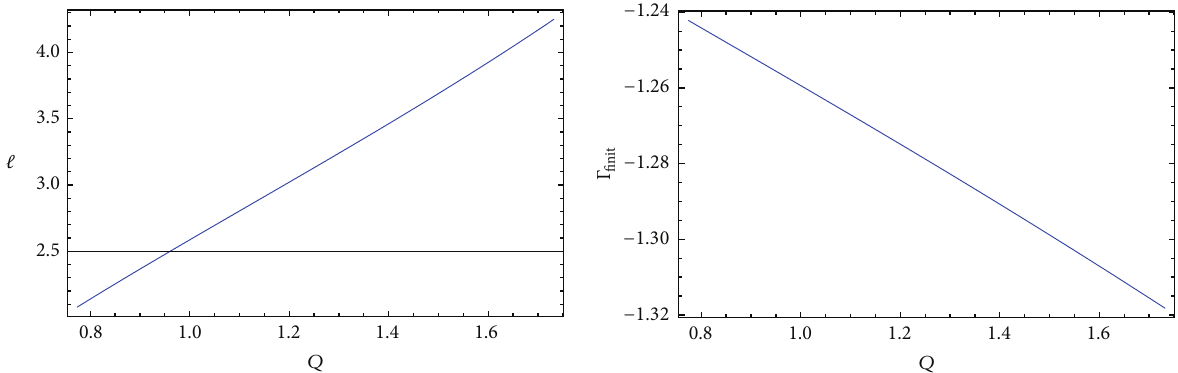
Figure 4: ℓ and Γ as functions of 𝑄 for the case of 𝑟 𝑡 = 𝑟 𝜙 . The numerical values are for 𝑟 𝐻 = 1 and 𝑅 = 𝐿 = 1 . Note that for all values of finite < 𝑟 𝑄 in the above plots, we have 𝑟 𝜙 𝐻